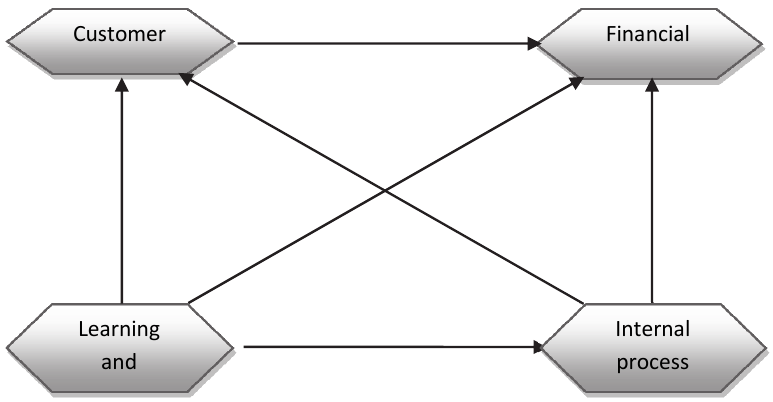
Fig. 4. A theoretical model of mutual correlations of four